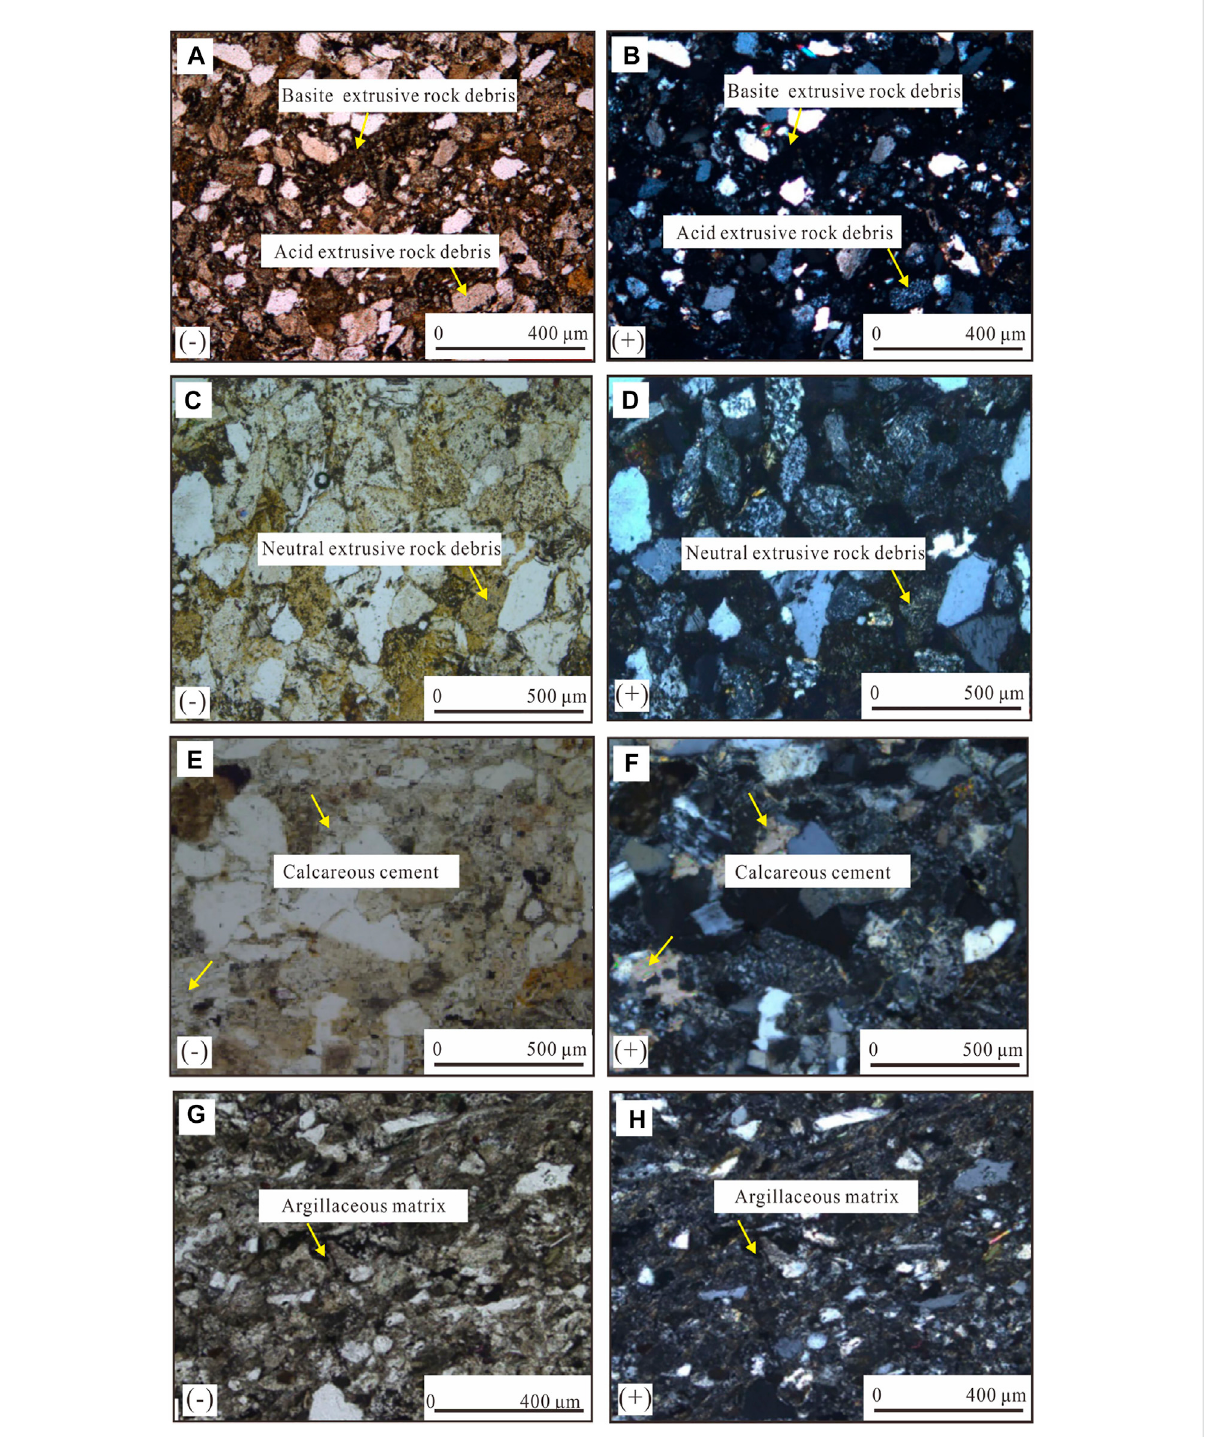
FIGURE 4 MicroscopiccharacteristicsofsandstonesinQuan3MemberintheFuxinUplift.Notes: (A) Feldspardebrissandstone,Jian25well,389.32m; (B) Feldspar debris sandstone, Jian 25 well, 389.32m; (C) Feldspar debris sandstone, Jian 24 well, 504.26m; (D) Feldspar debris sandstone, Jian 24 well, 504.26m; (E) Calcareous sandstone, Ji+28 – 15.1 well, 1364.68m; (F) Calcareous sandstone, Ji+28 – 15.1 well, 1364.68m; (G) Argillaceous siltstone, Mu+126 – 024 well, 954.07m; (H) Argillaceous siltstone, Mu+126 – 024 well,